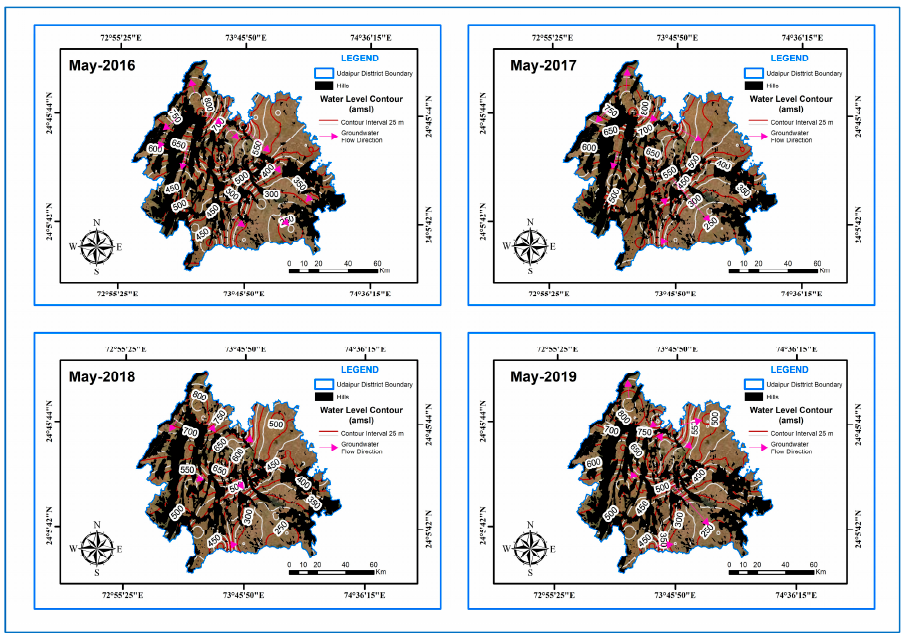
Figure 11. The water-level distribution, specifically contour information during pre-monsoon season in the Udaipur district.